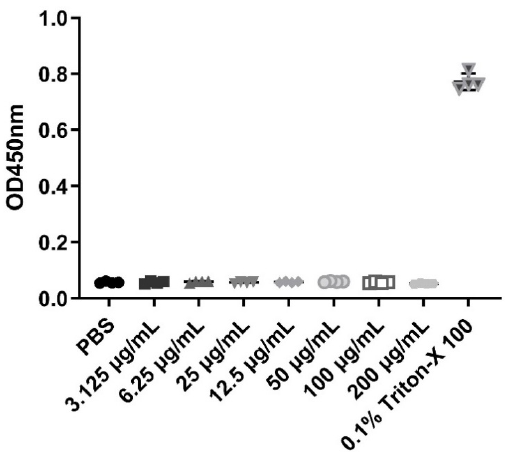
Figure 3. The hemolytic activity of recombinant pBD129 protein of E. coli expression system. The X-axis coordinates corresponding to the symbols in the figure are the respective groups. The same volume PBS and 0.1% Triton X-100 were used as negative controls and positive controls, respectively. n = 3.